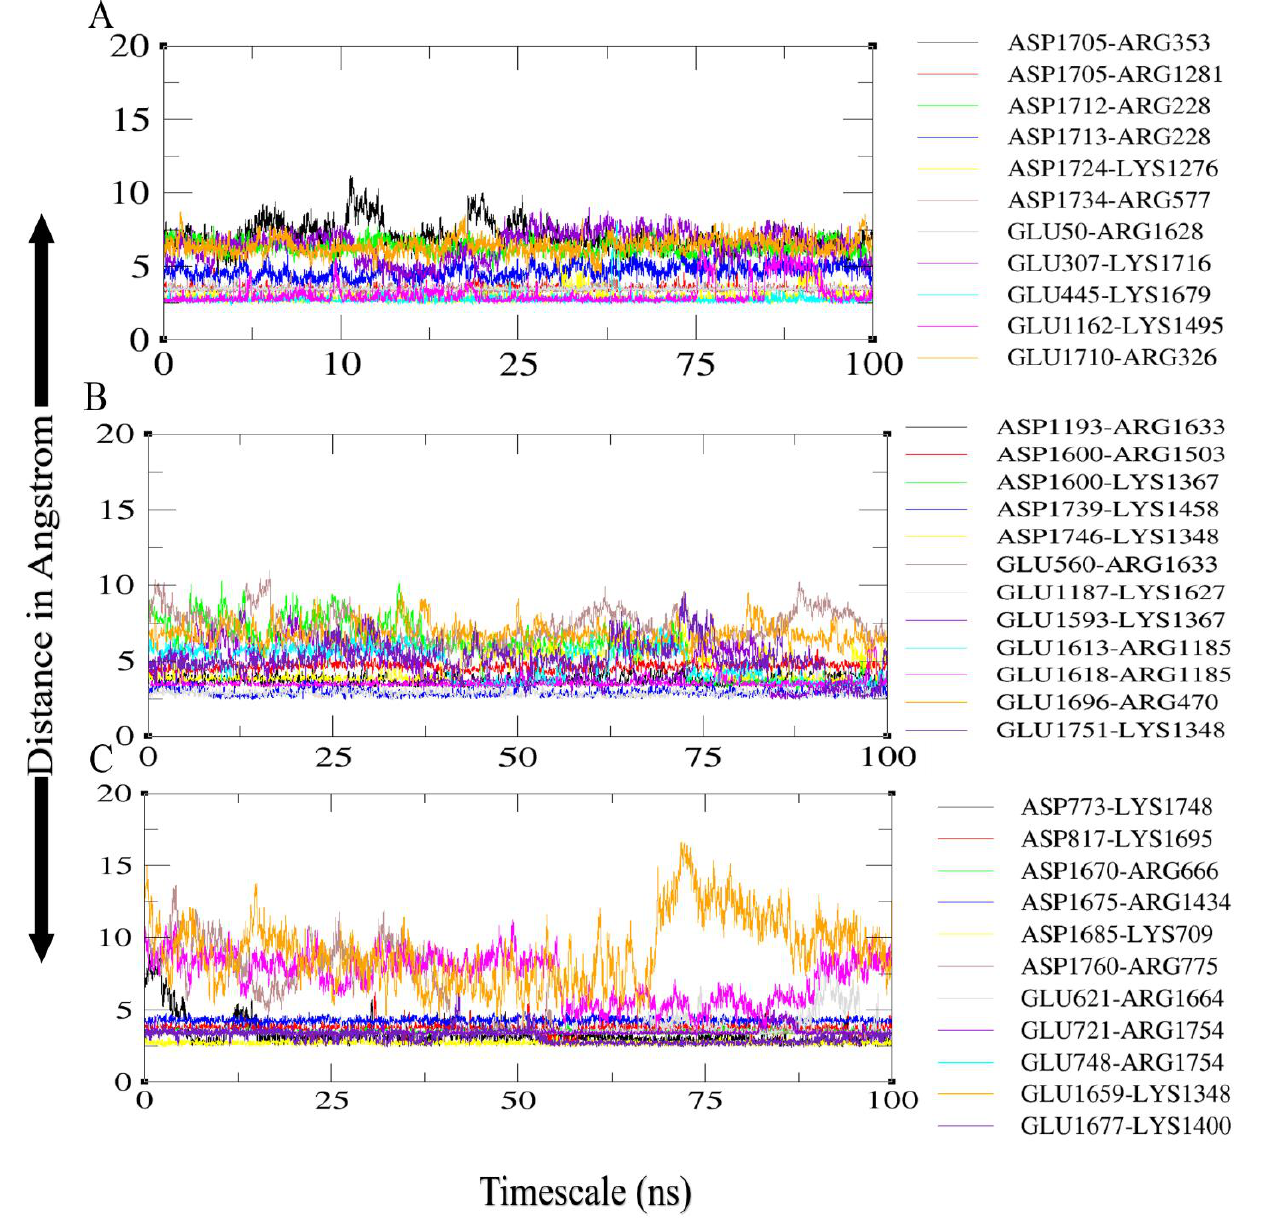
Figure 11. Salt bridges formed between receptor and vaccine: ( A ) TLR4-agonist vaccine with TLR4; ( B ) β -defensin vaccine with TLR4; ( C ) 50S ribosomal protein L7/L12 vaccine with TLR4.